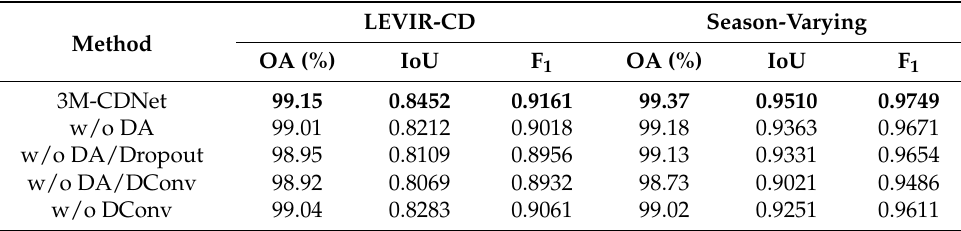
Table 8. The contribution of DA, Dropout, and DConv on the